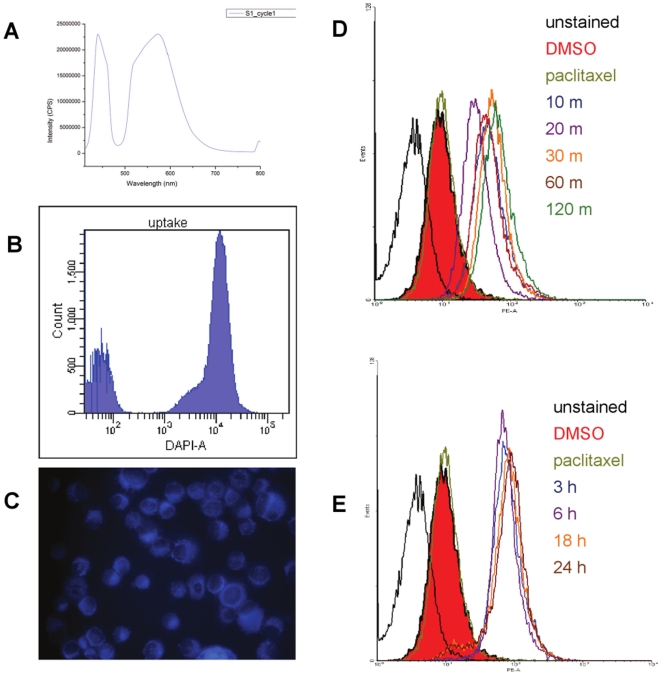
The fluorescent properties of TP421 were exploited to determine cellular uptake and localization.Upper panel, optimal excitation and emission spectra are 396 and 450 nm, respectively for TP421, as determined using steady state fluorescence spectroscopy. The graph shows the emission spectra of TP421. Middle panel, TP421 uptake can be monitored by flow cytometry. Histogram shows fluorescence intensity measured at excitation 355 nm and emission 450 nm prior to, and following treatment with TP421. Microscopy of cytospin of TP421 treated cells show subcellular localization suggestive of mitochondrial accumulation. Mitochondrial superoxide production is an early and sustained event in TP action. MDA-MB-435 cells were treated with 5 µM TP197 and superoxide production was measured at various timepoints using MitoSOX Red, a fluorogenic indicator of mitochondrial superoxide production. (D) Histogram overlays show the effect of TP treatment at early timepoints. Superoxide production increased as early as 10 minutes post-treatment (dark blue line) and maintained similar levels at 20 (purple line), 30 (orange line), 60 (brown line), and 120 (green line) minutes post-treatment. Treatment with 500 nM paclitaxel (olive line) did not increase superoxide levels above those seen in vehicle (solid red) treated cells. (E) Superoxide production is increased through later timepoints. TP-induced superoxide production was measured 3 h (dark blue line), 6 h (purple line ), 18 h (orange line), and 24 h (brown line) after TP197 treatment. Compared to vehicle (solid red) and paclitaxel (olive line) controls, TP197 caused a marked increase in superoxide production.